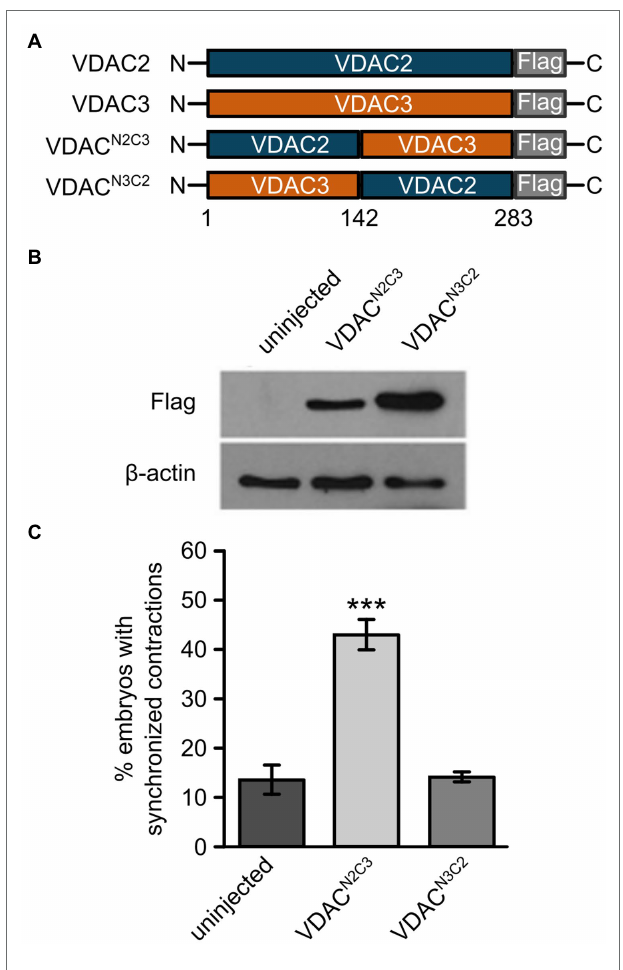
FIGURE 5 | The N-terminal domain of VDAC2 contains critical elements for its cardioprotective activity. (A) Schematic representation of VDAC2/3 chimeric constructs. Reciprocal chimeric constructs were generated by swapping the N- and C-terminal halves of VDAC2 and VDAC3 and tagging a FLAG epitope at the C-terminal end. VDAC N2C3 : The N-terminal half of VDAC2 (amino acids 1 to 142) was fused to the C-terminal half of VDAC3. VDAC N3C2 : The N-terminal half of VDAC3 was fused to the C-terminal half of VDAC2. (B) Western blot with anti-FLAG antibody after SDS-PAGE with lysates from 30 hpf uninjected embryos or embryos injected with 60 pg. FLAG-tagged chimeric VDAC mRNA. β -actin was used as a loading control. (C) Injection of VDAC N2C3 mRNA restored synchronized cardiac contractions in 1-day-old tremblor/ncx1h embryos (43.4 ± 2.8%, N = 3, n = 168 compared to 13.7 ± 3.1%, N = 3, n = 156 in uninjected siblings), whereas injection of VDAC N3C2 mRNA fails to produce this effect (14.2 ± 1.2%, N = 3, n = 162). Overall rescue percentages represent the mean rescue percentage ± s.e.m. from N independent experiments, using a total of n